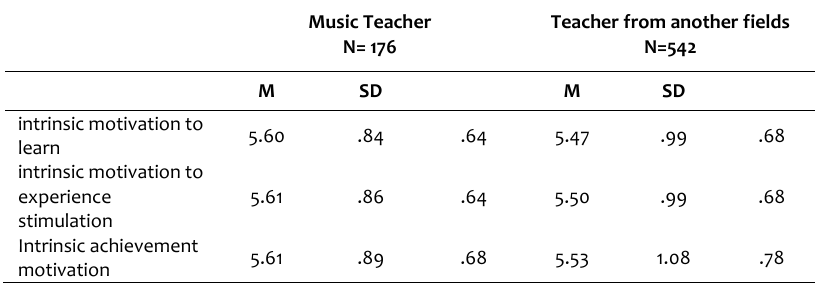
Table 1. Intrinsic Motivation.